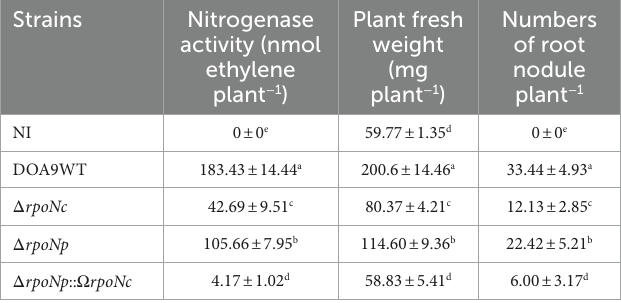
TABLE 1 Symbiotic properties of Bradyrhizobium sp. DOA9 wildtype and rpoN mutant strains.